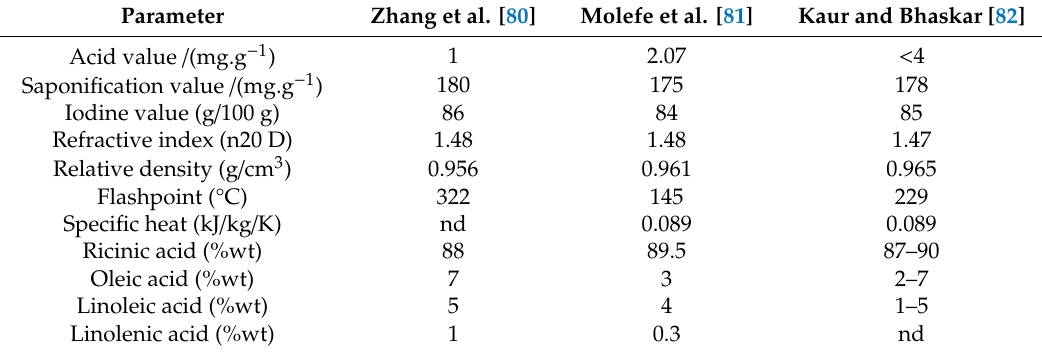
Table 6. Main characteristics of raw castor